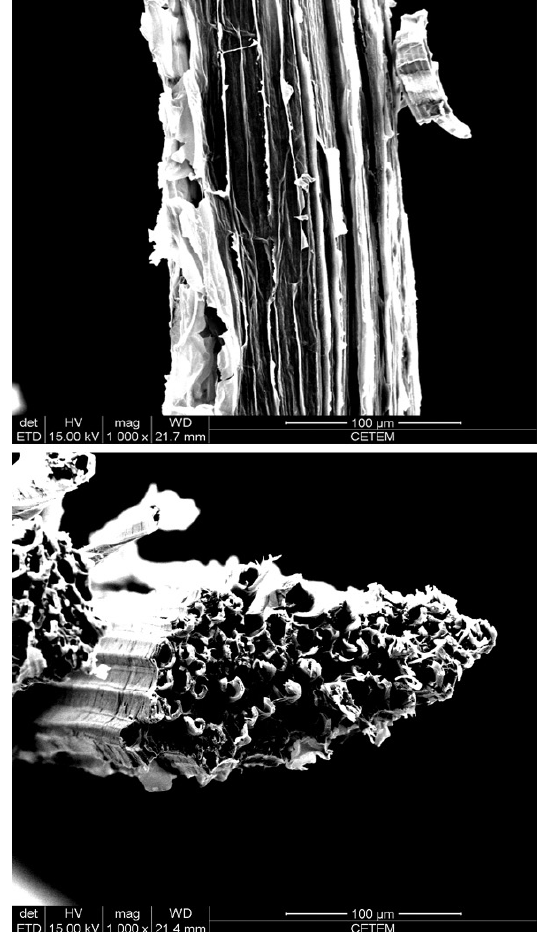
Figure 4. Sisal Fibers and Recycled HDPE TGA test result in nitrogen atmosphere.